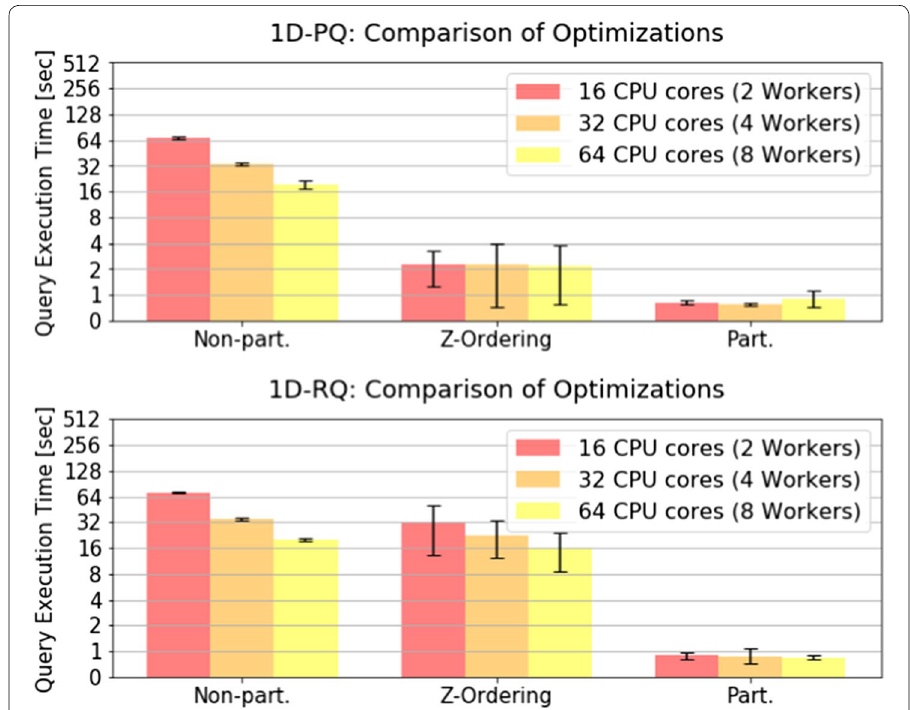
Fig. 5 Response times for 1D point queries (top figure: 1D-PQ) and 1D range queries (bottom figure: 1D-RQ) on the synthetic dataset. The cardinality for all attributes is 10 4 . The queries are of the from WHERE a1 where a 1 is a non-partitioned, partitioned or Z-ordered attribute,